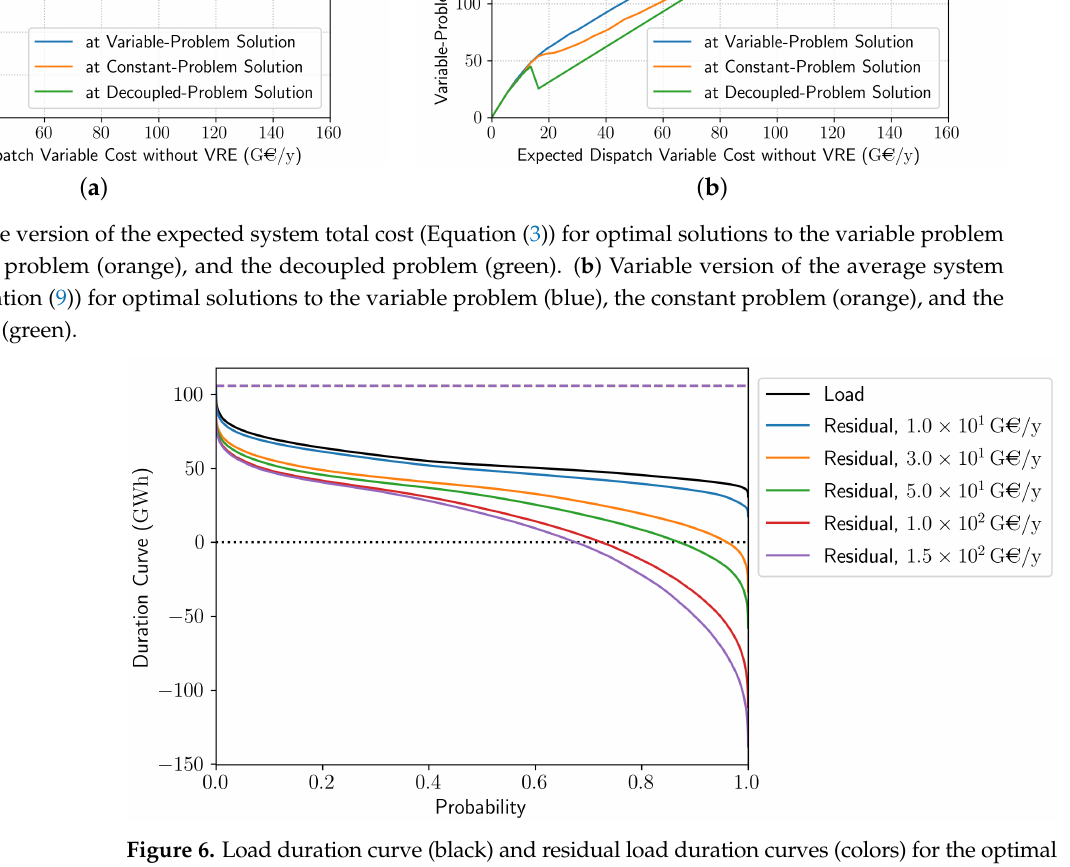
Figure 6. Load duration curve (black) and residual load duration curves (colors) for the optimal solutions of the variable problem at selected values of the expected system total cost without variable renewable energy. The dashed line represents the total installed dispatchable capacity, x Di